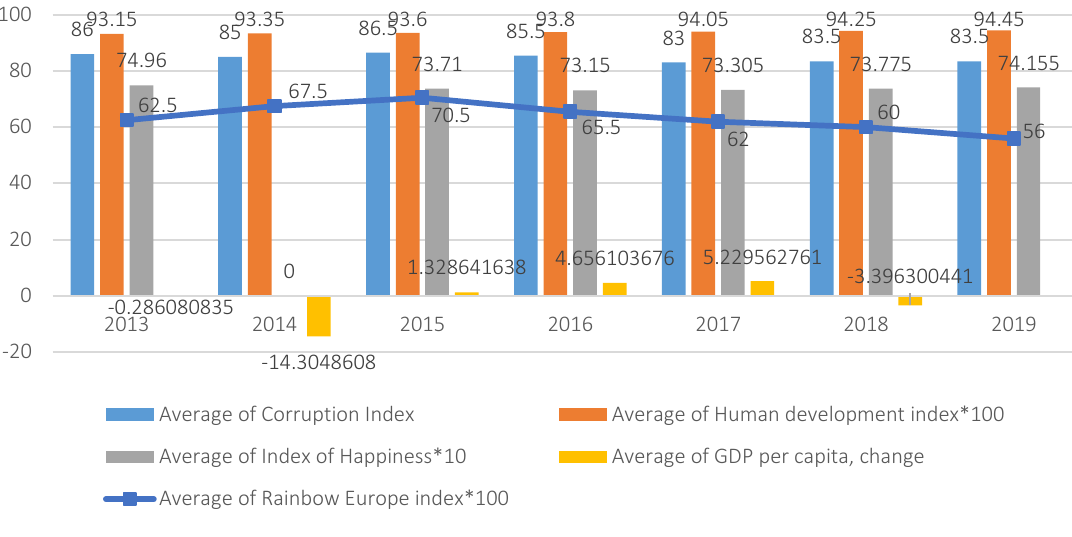
Figure 4. Average values of given indicators with a clear line of Rainbow Europe Index for Sweden and the